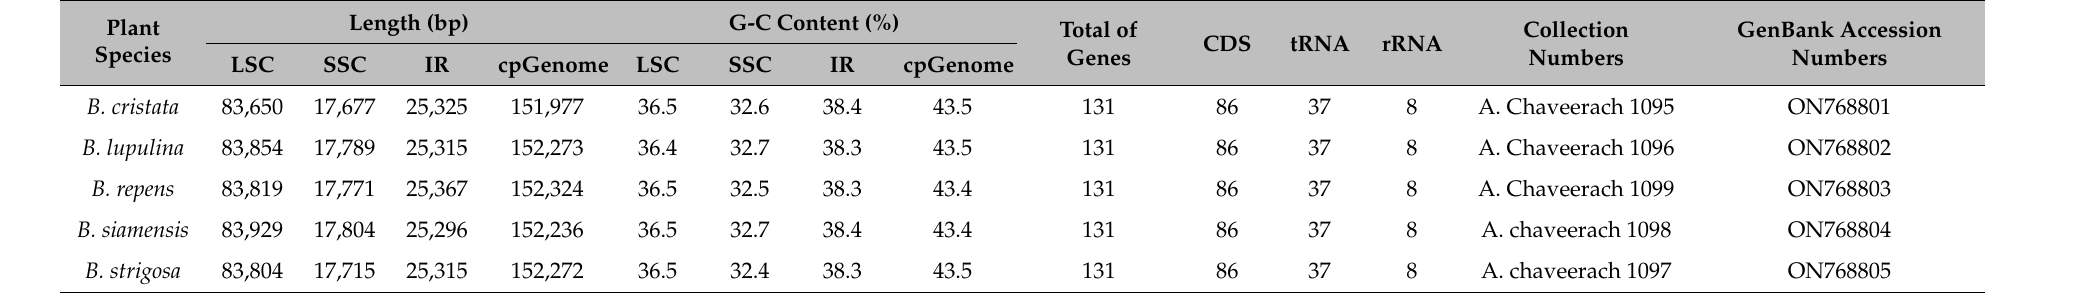
Table 1. Chloroplast genome features of Barleria